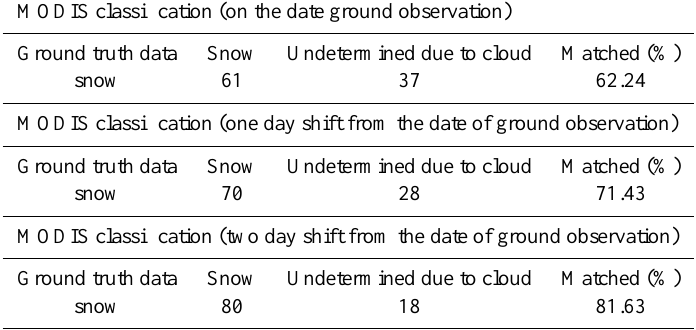
Table 2. Summary of analyses for MODIS images in winter 2002–2003. MODIS classification (on the date ground